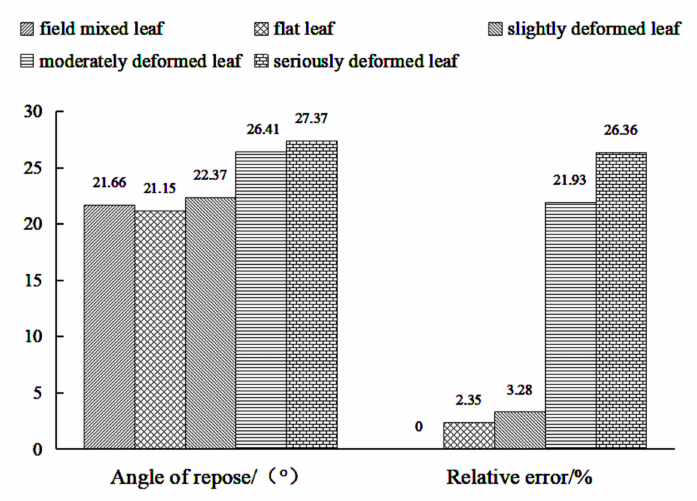
Figure 9. The effect of sugarcane leaf shape on the angle of